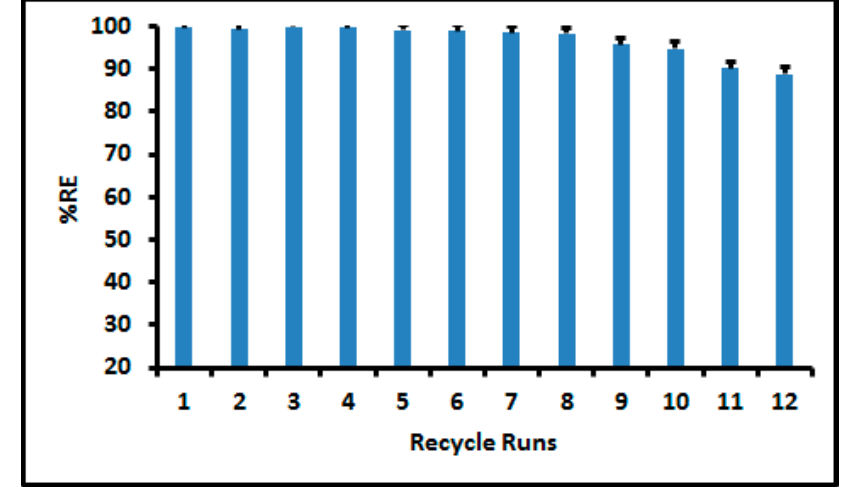
Figure 3. Percentage removal efficiency versus recycle runs for the regenerated Figure 4. Percentage removal e ffi ciency versus recycle runs for the regenerated MWCNT-Fe3O4@Zeo MWCNT-Fe3O4@Zeo nanocomposite for the removal of As at optimal conditions performed at room nanocomposite for the removal of As at optimal conditions performed at room temperature. adsorption time